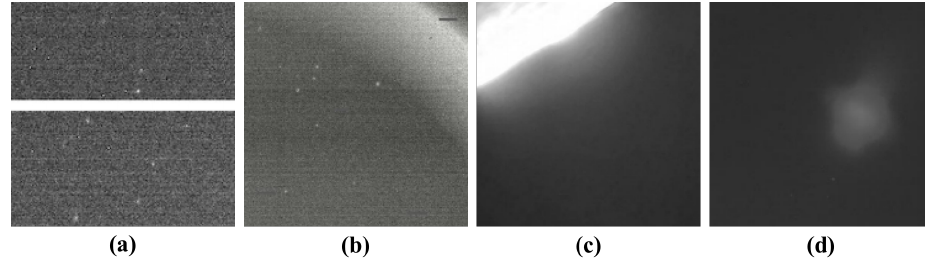
Figure 2. Characteristics of large-area interference: ( a ) linear interference; ( b ) design defects of light shield; ( c ) reflected light enters the star tracker; and ( d ) reflected light from celestial bodies enters the field of view.